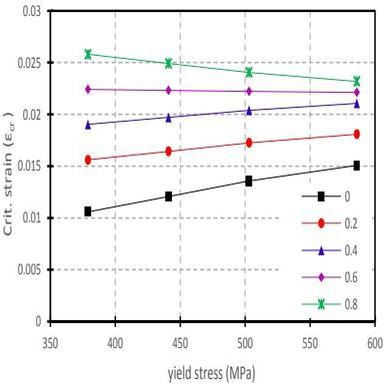
Plot of εcr vs. σ0.5 for YPT DT1 pipe (YPL = 1.25).